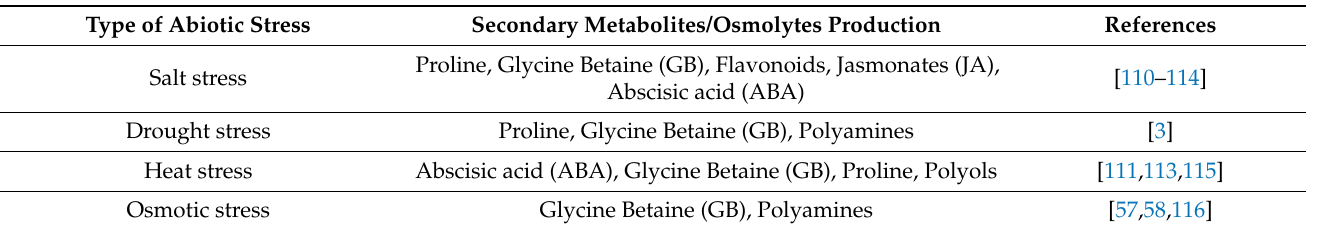
Table 1. Osmolyte production in plants in response to salt, drought, heat, and osmotic stress. Type of Abiotic Stress Secondary Metabolites/Osmolytes